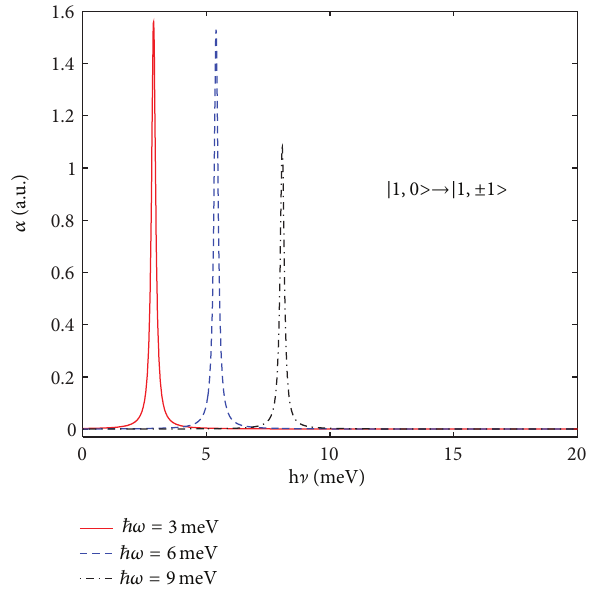
Figure 5: The optical absorption coefficients as a function of the incident photon energy for 𝐵 = 0 and different confinement